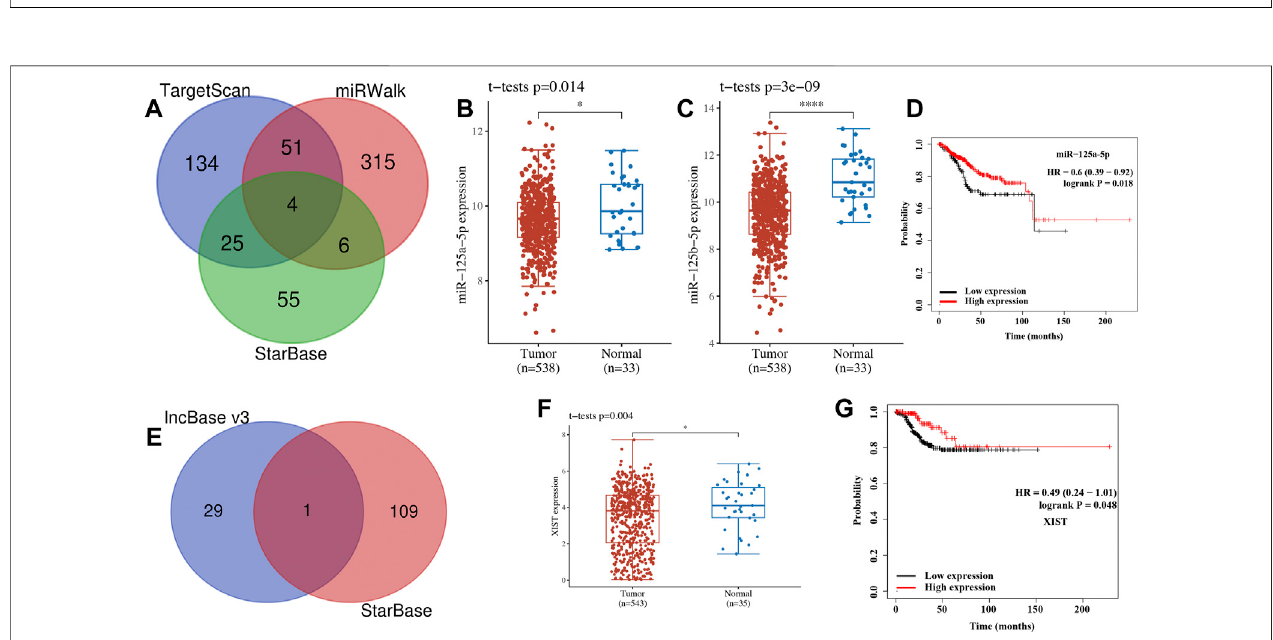
FIGURE 9 | TMB and MSI of cuproptosis-related prognostic biomarkers in uterine corpus endometrial carcinoma (UCEC). (A-C) Correlation between the expression of CDKN2A, GLS, and LIPT1 and TMB score in UCEC. (D – F) Correlation between the expression of CDKN2A, GLS, and LIPT1 and MSI score in UCEC. TMB, tumor mutation burden; MSI, microsatellite instability.